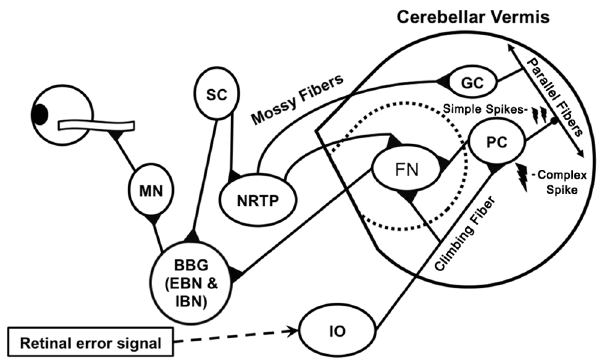
Figure 6. Schematic representation of a sagittal view of the cerebellar ‘‘oculomotor’’ vermis - brainstem circuitry involved in the adaptation of saccadic eye movements. Retinal error information reaches the inferior olive (IO), which in turn projects ascending climbing fibers that create complex spike action potentials at synapses on the Purkinje cell (PC) body and proximal dendrites. PCs also receive input via mossy fibers projecting from the nucleus reticularis tegmenti pontis (NRTP), which receives a saccade command from the superior colliculus (SC). Rapid, simple spike discharges occur at the synapses of mossy fiber-parallel fiber inputs to PCs. The complex spike firing of the climbing fiber-PC synapses induces a long-term depression (LTD) of simple spikes that is thought to be the mechanism guiding saccade adaptation. Changes in PC simple spike bursts modify saccade trajectories by altering the level of inhibitory output to fastigial nuclei (FN), which in turn modulate inhibitory (IBN) and excitatory burst neuron activity (EBN) in the brainstem burst generator (BBG). The BBG innervates abducens motoneurons (MN) that control horizontal eye movements via lateral and medial extraocular